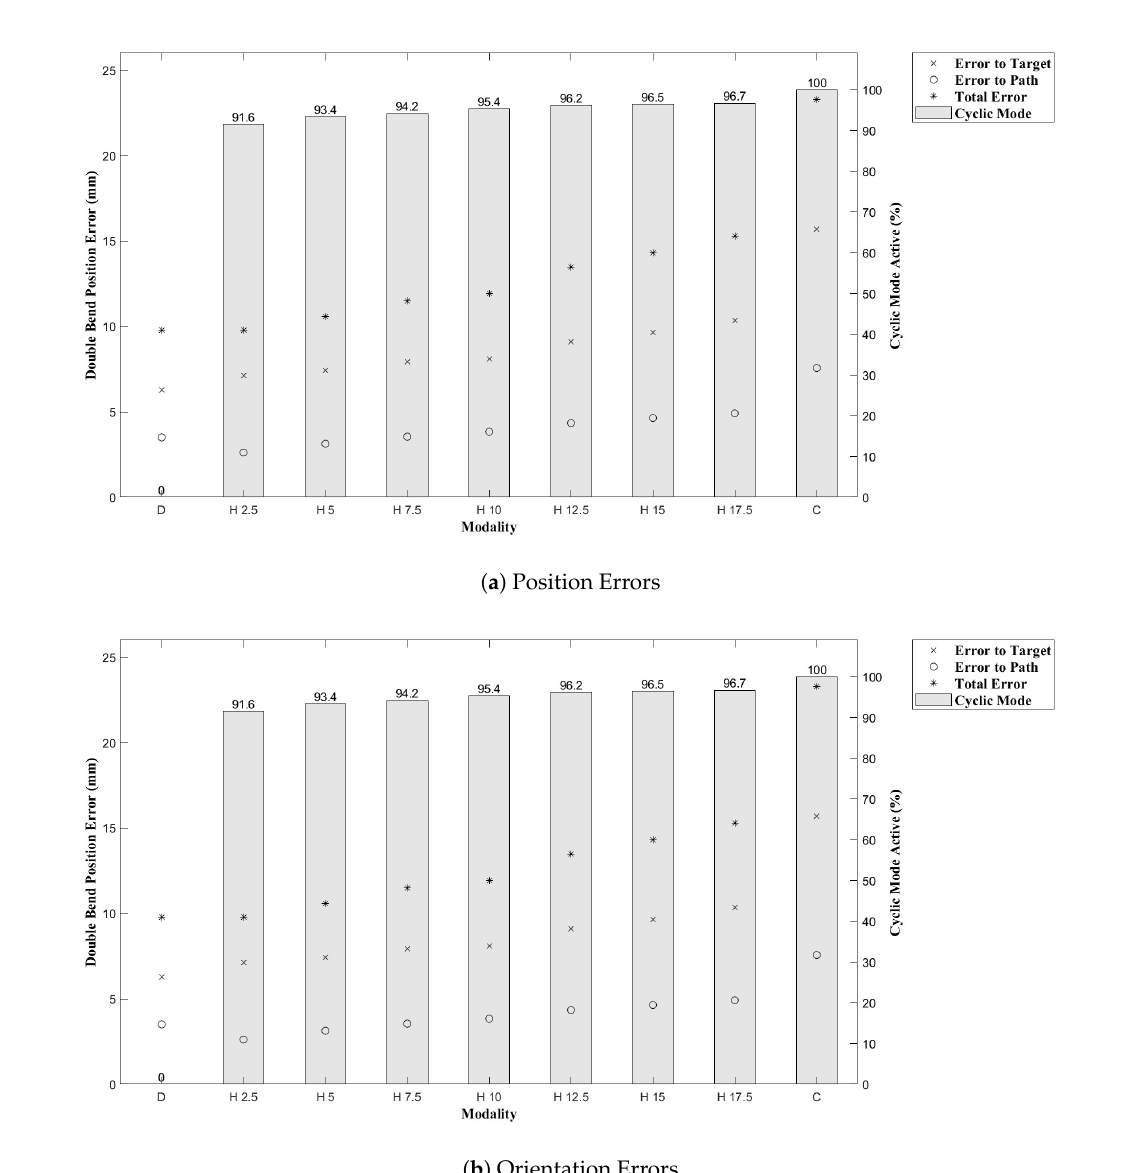
Figure 11. Double bend trajectory errors with per cent CAC active time shown as the bar